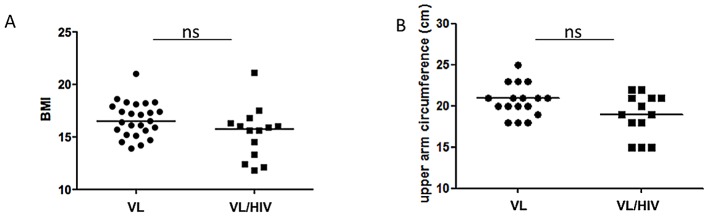
BMI and upper arm circumference.(A) Measurements of BMI (VL patients: n = 25, VL/HIV patients: n = 14) and (B) circumference of the upper arm (VL patients: n = 17, VL/HIV patients: n = 13). The straight line represents the median. NS = not significant.